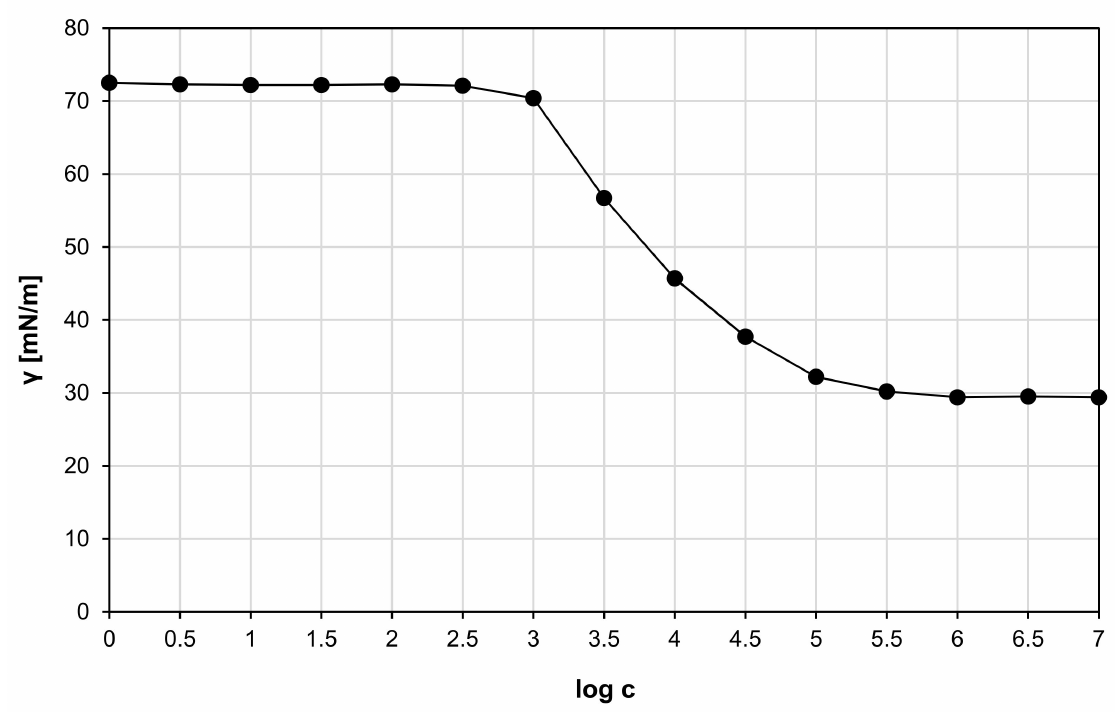
Figure 1. Surface tension function versus the decimal logarithm of the rhamnolipids concentration at room temperature in